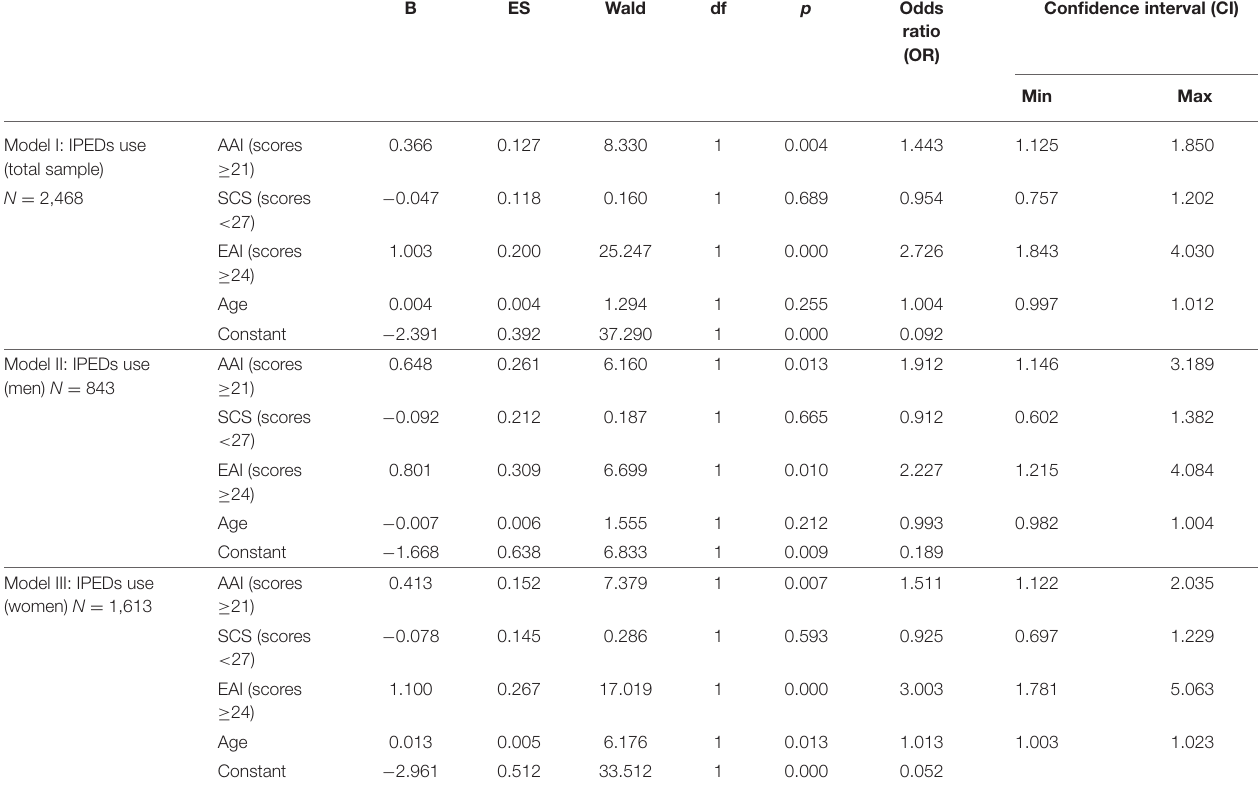
B ES Wald df p Odds